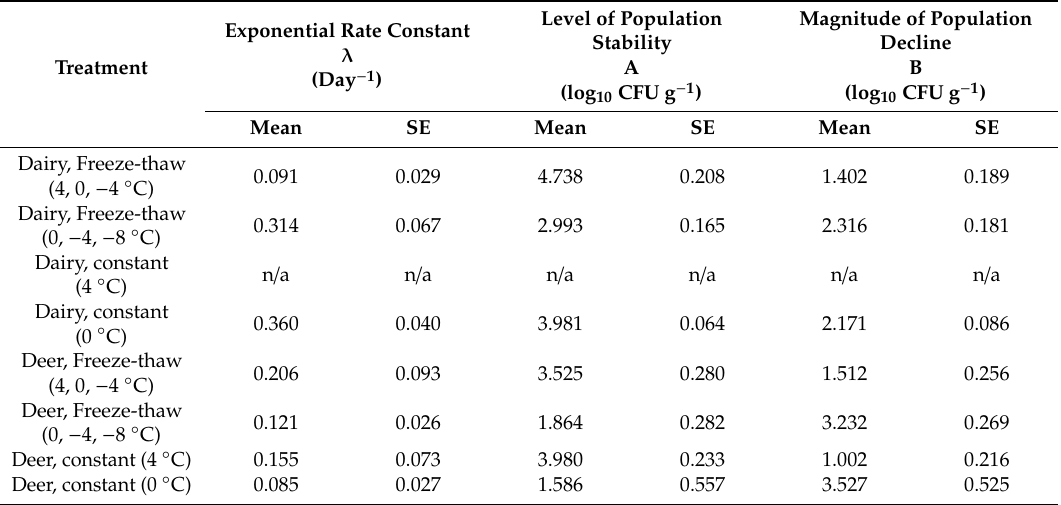
Table 3. Parameter values for intestinal enterococci die-o ff associated with non-linear models.